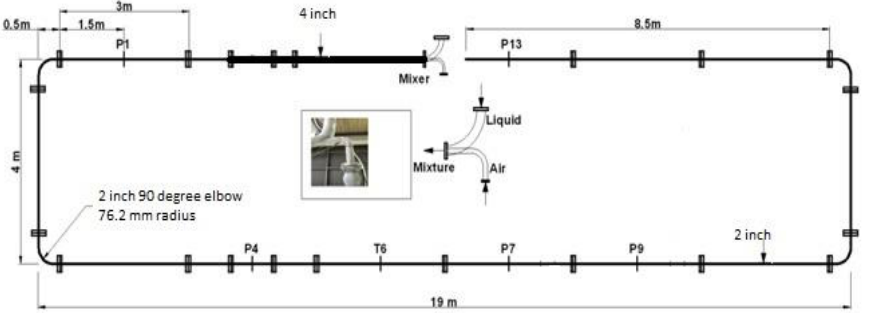
Figure 5. Top view schematic of the physical configuration of the 2-inch test loop, mixing section, and instrumentation [30] .